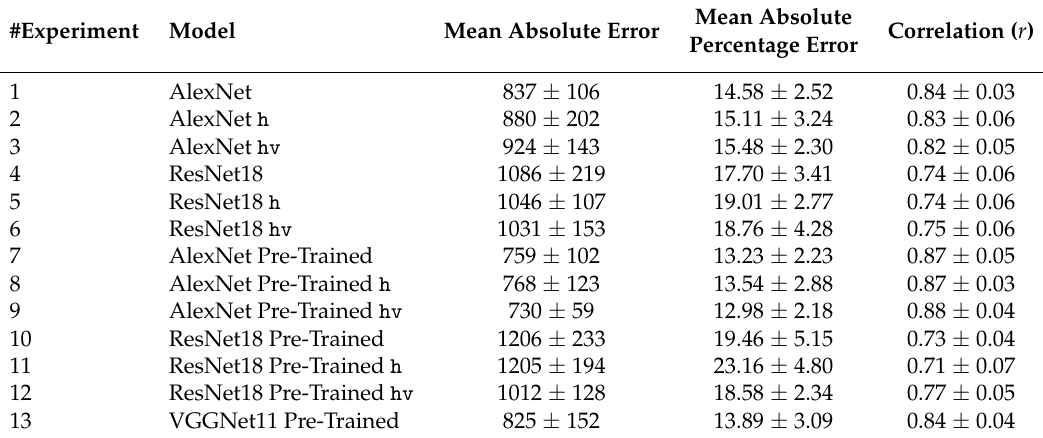
Table 2. Experimental results. Experiment #9’s results present the lowest MAE (mean absolute error) and highest correlation. It is good to remind the reader that y i , ranging from 1556.00 kg · ha − 1 to